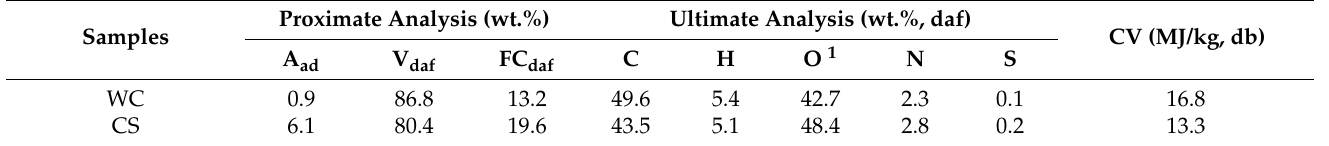
Table 1. Proximate and ultimate analysis of WC and CS. Proximate Analysis Samples